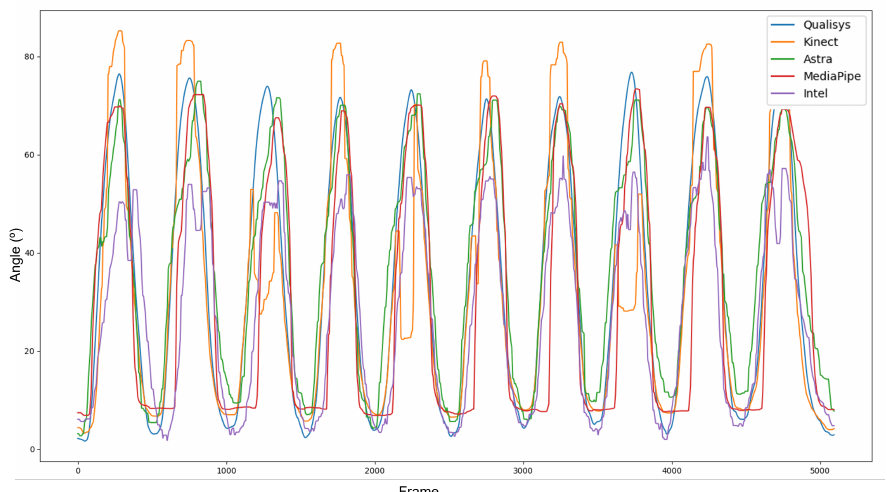
Figure 8. Synchronized and interpolated